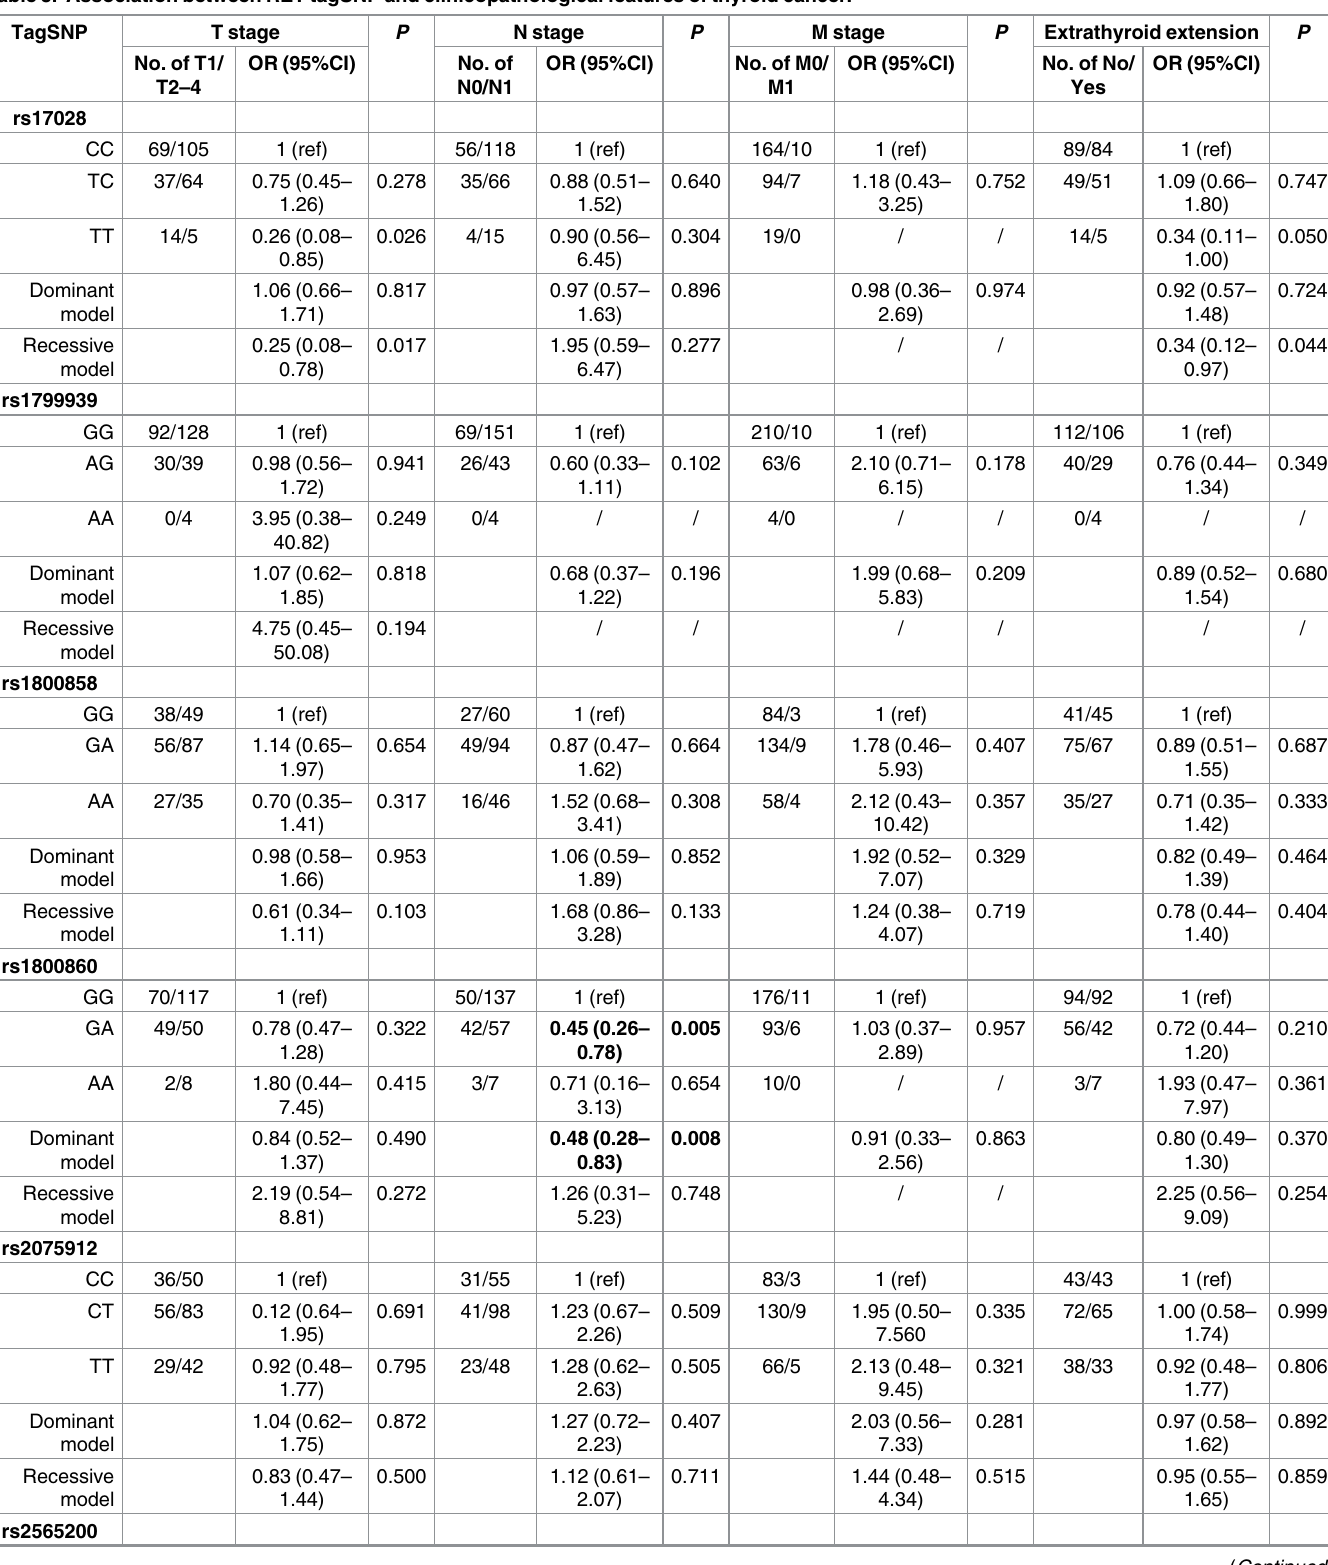
Table 3. Association between RET tagSNP and clinicopathological featuresof thyroid